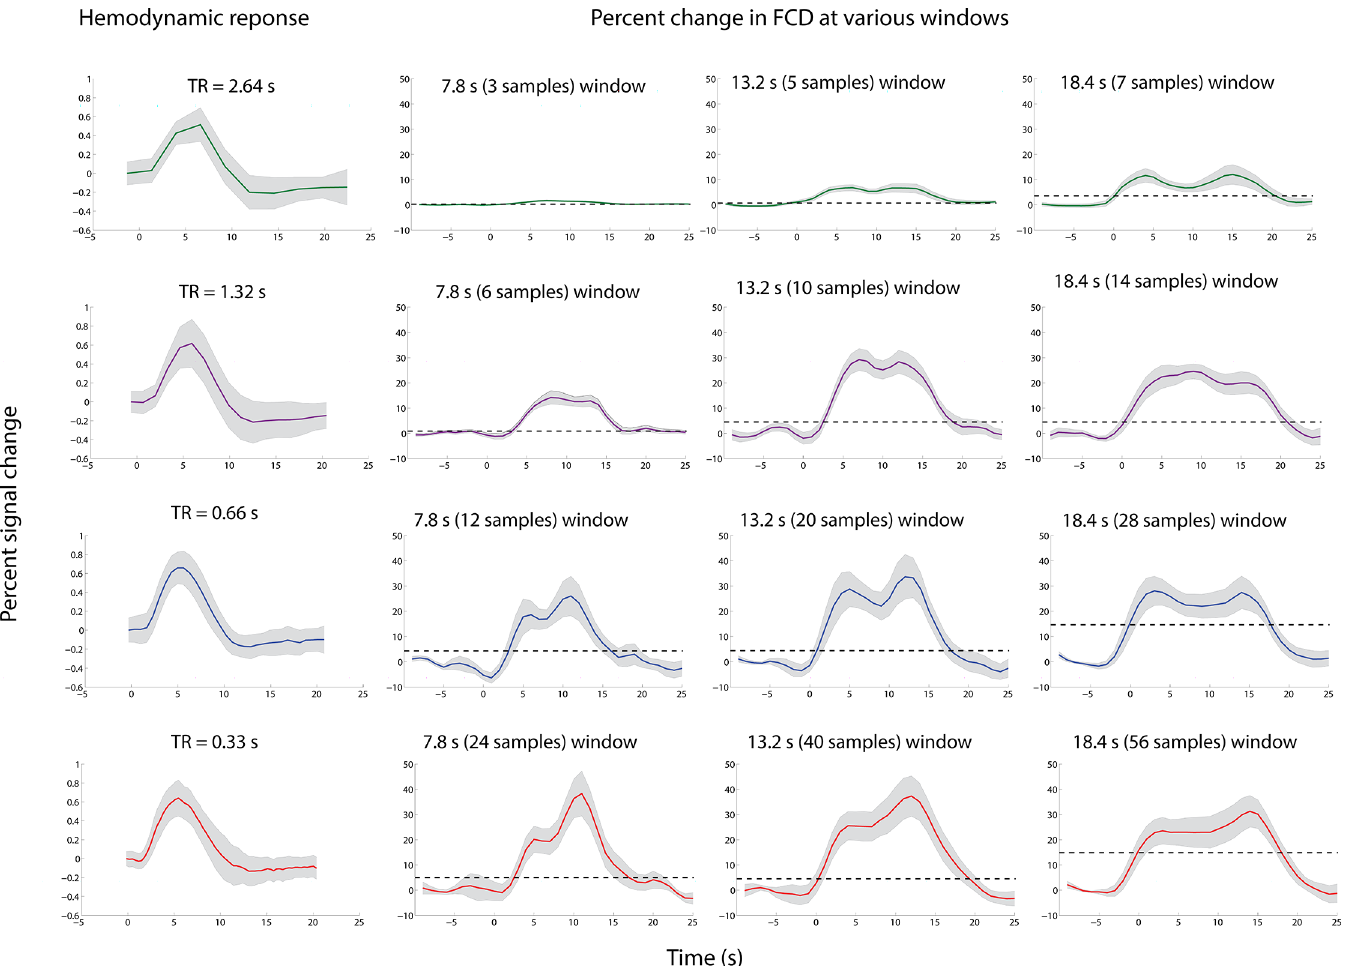
Fig 2. Comparison between the FCD percent change and the hemodynamic response. Percent change in FCD with stimulation beginning at 0 s for TR of 2.64 s (in green), 1.32 s (in purple), 0.66 s (in blue) and 0.33 s (in red) at various window sizes, along with the hemodynamic response. All these measures were computed in the region defined by the localizer. The 0 s indicates the stimulus onset. The horizontal dash line is a marker for significance (twice the mean standard error of the baseline).